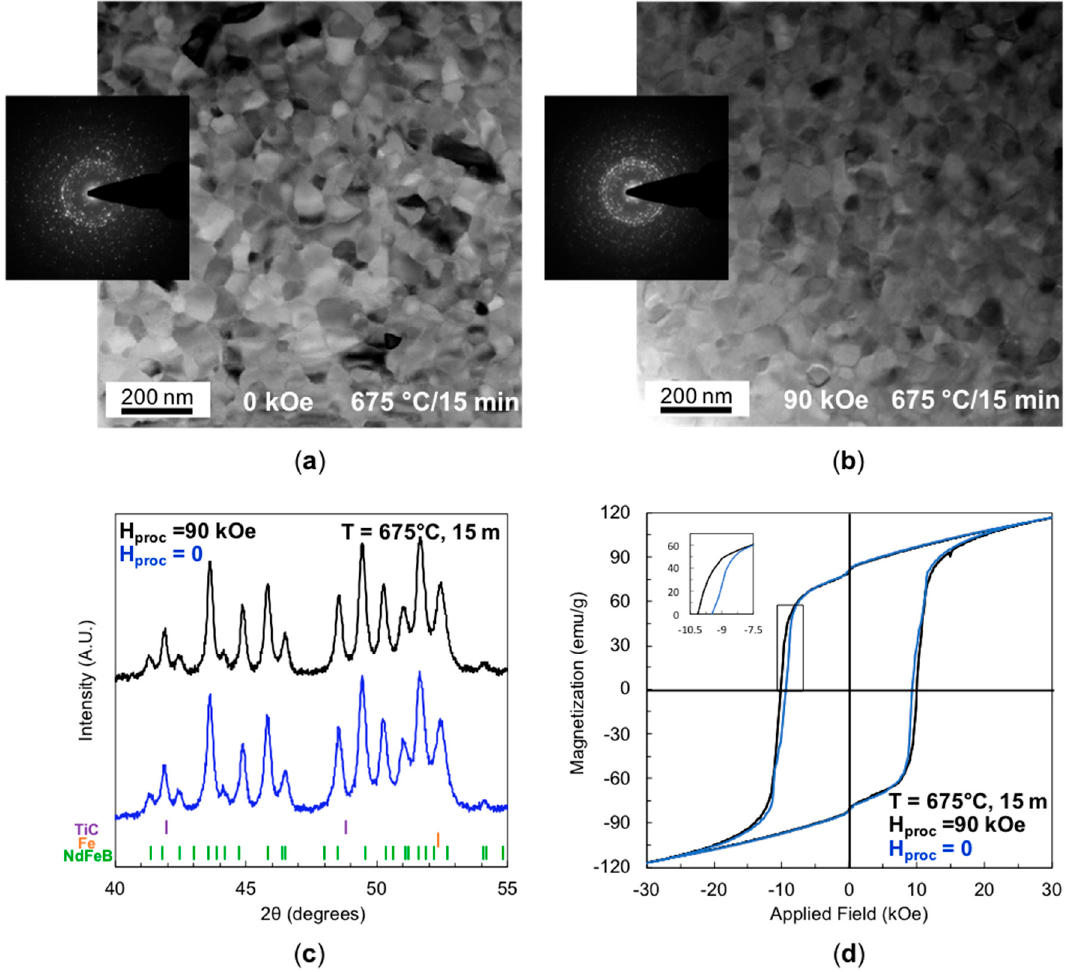
Figure 4. TEM bright field micrographs with SAD pattern insets from fully crystallized Nd 2 Fe 14 B ribbons annealed at 675 °C for 15 min at ( a ) zero-field and ( b ) in an applied field of 90 kOe, along with the ( c ) XRD (Co K α 1 radiation, λ = 1.7890 Å) showing apparent identical spectra, and ( d ) VSM hysteresis curves of the fully crystallized ribbons at zero-field (blue) and in an applied field of 90 kOe (black) showing the magnetic behavior with an inset revealing a difference in coercivity.